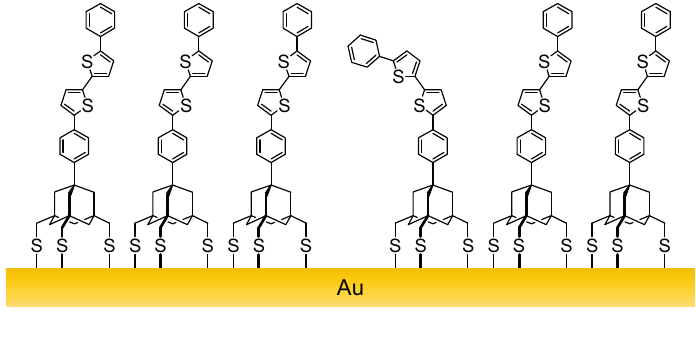
Figure 2. Schematic representation of a SAM of anti - 3b containing the syn